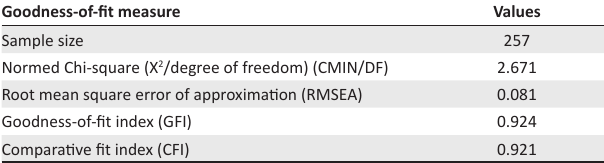
TABLE 10: Goodness-of-fit indices for the structural model on leadership effectiveness and its constructs.